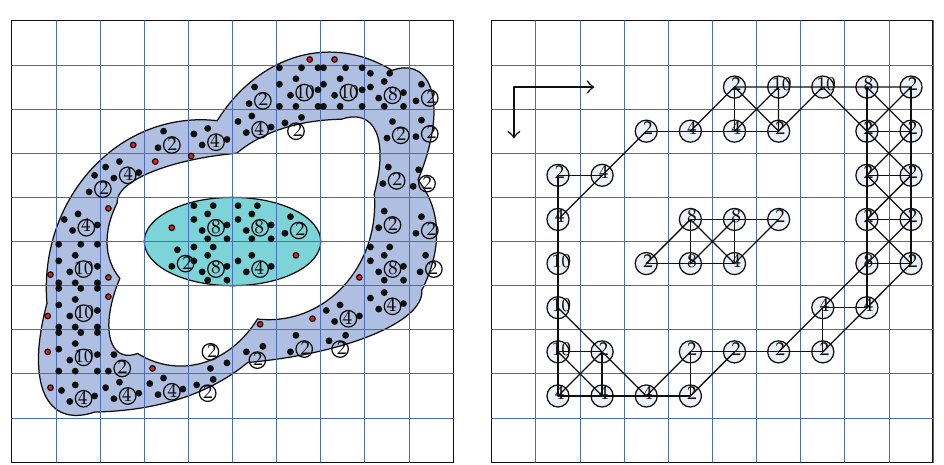
Figure 10: A data example with graph generated. The numbers in circles are the values of p in